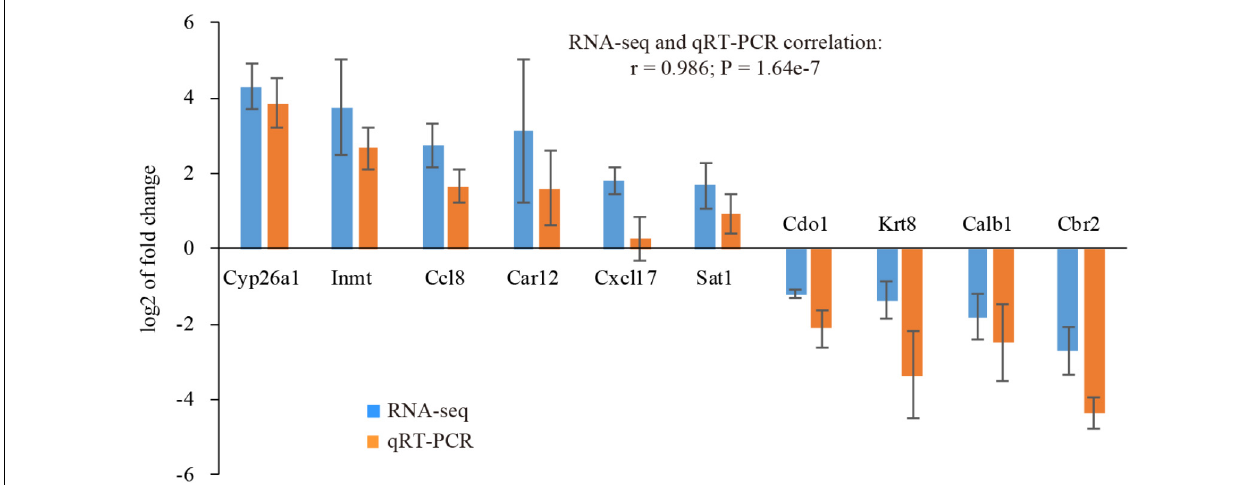
FIGURE 2 | Validation of selected genes using qRT-PCR. Fold changes determined by RNA-seq and qRT-PCR were presented as the mean ± SEM. Statistical significance was reached at P < 0.05 for all genes except Cxcl17. n = 3.